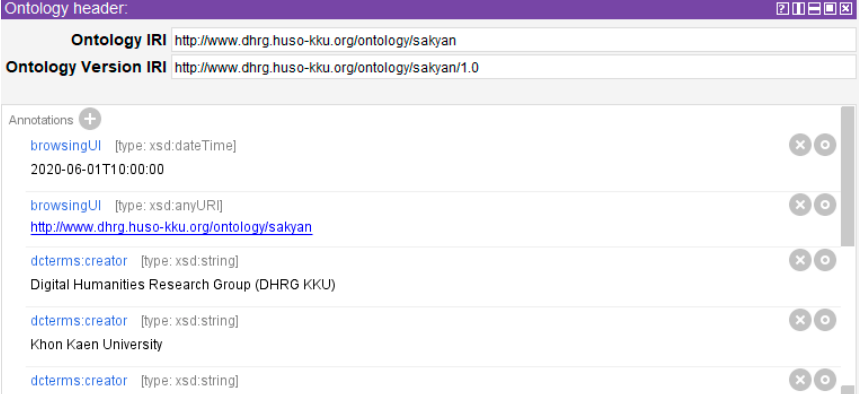
Figure 12. Reevaluation result after reparation activity.